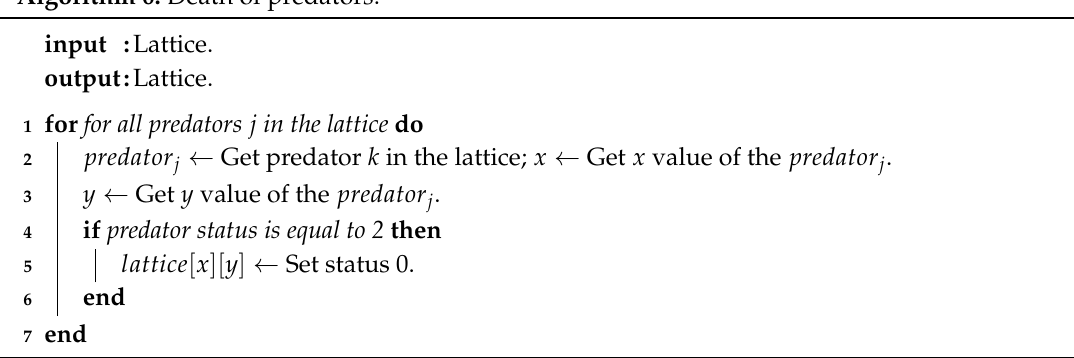
Algorithm 6: Death of